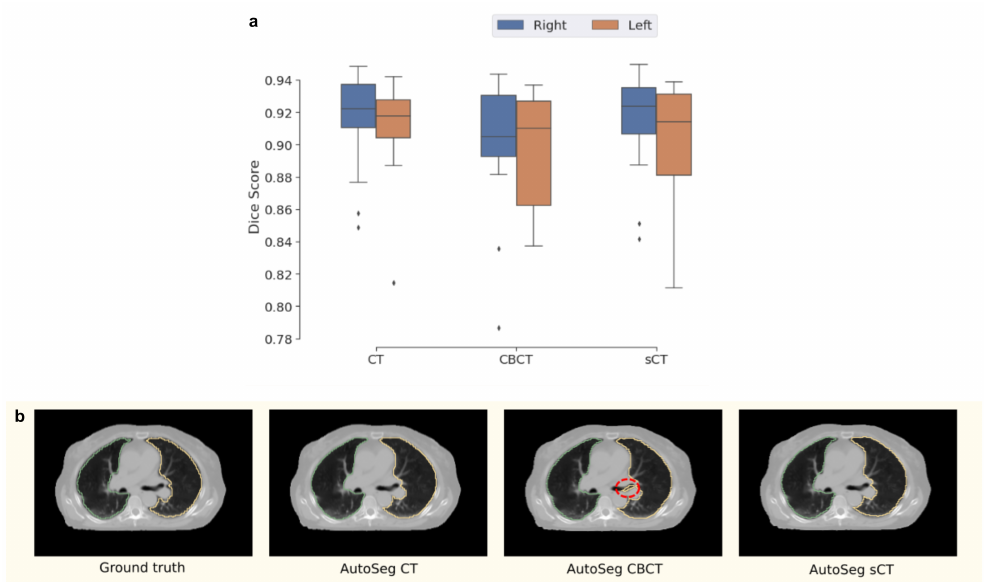
Figure 7. Box plot showing Dice scores for segmentation of left and right lungs using CT, CBCT, and sCT images as input ( a ). Visuals of the segmentation generated by using different inputs to the automated segmentation pipeline along with the ground truth segmentation are also shown ( b ). Note that all segmentations are shown on the CT as the original segmentations were drawn on the CT. The red indication points out a discontuinity in the contour generated on the CBCT image which is rectified when the sCT is used. Table 4. Mean Dice scores for left and right lung segmentations for the CT, CBCT, and sCT images as input to the automated segmentation